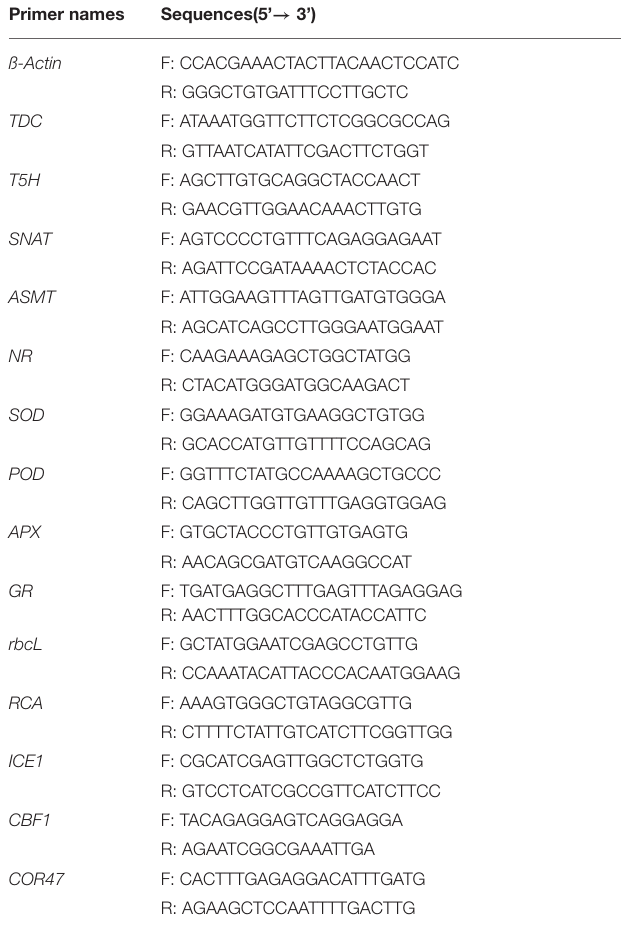
TABLE 1 | The primer sequences of quantitative real-time PCR